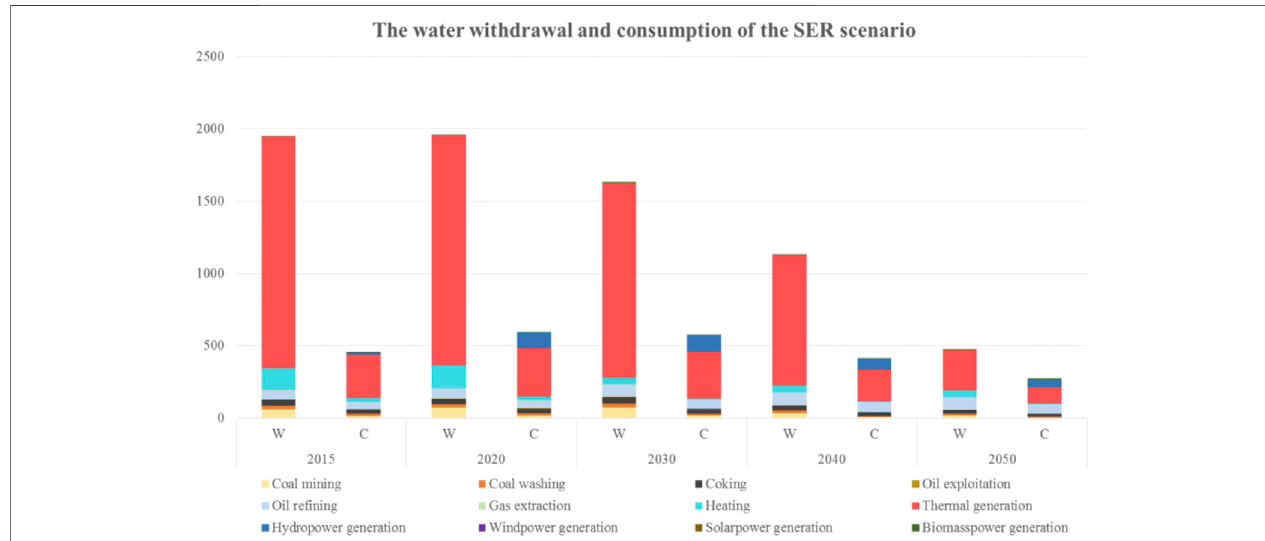
FIGURE 7 | The water withdrawal and water consumption of each sector in the strong emission reduction (SER) scenario. Note: W represents water withdrawal, and C represents water consumption.